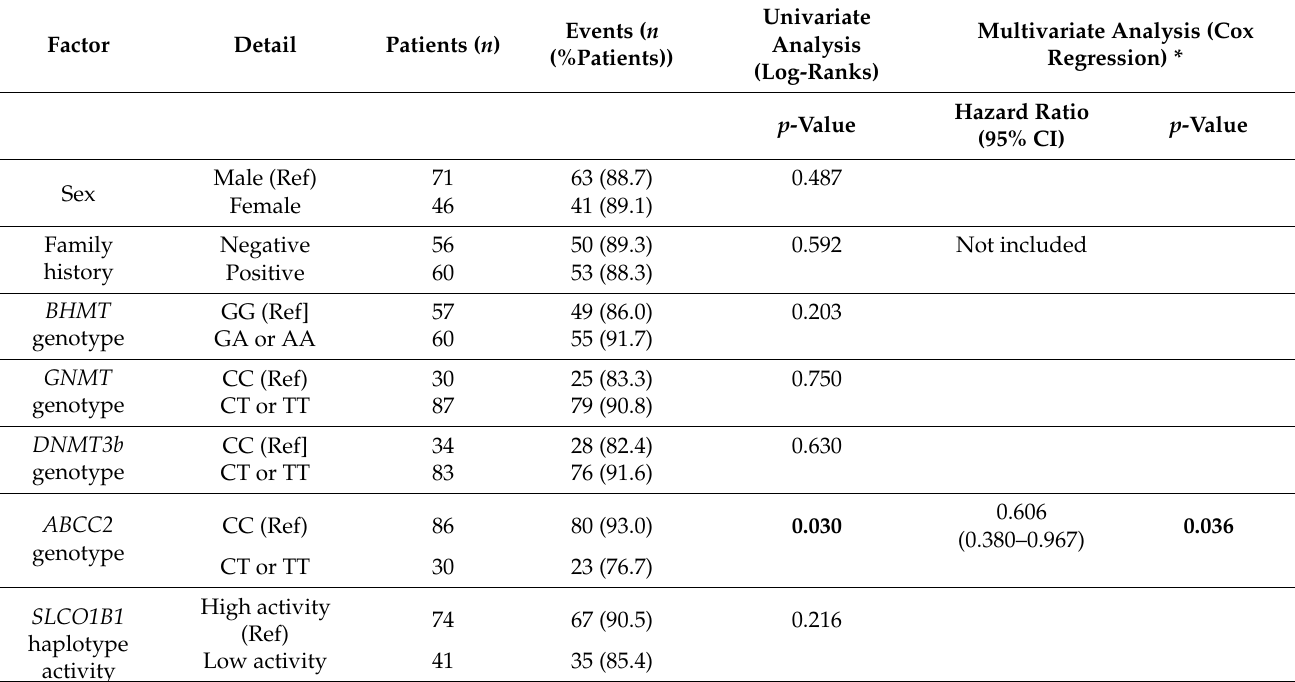
Table 3. Determinants of methotrexate drug survival from the results of the univariate tests and multivariate analyses.